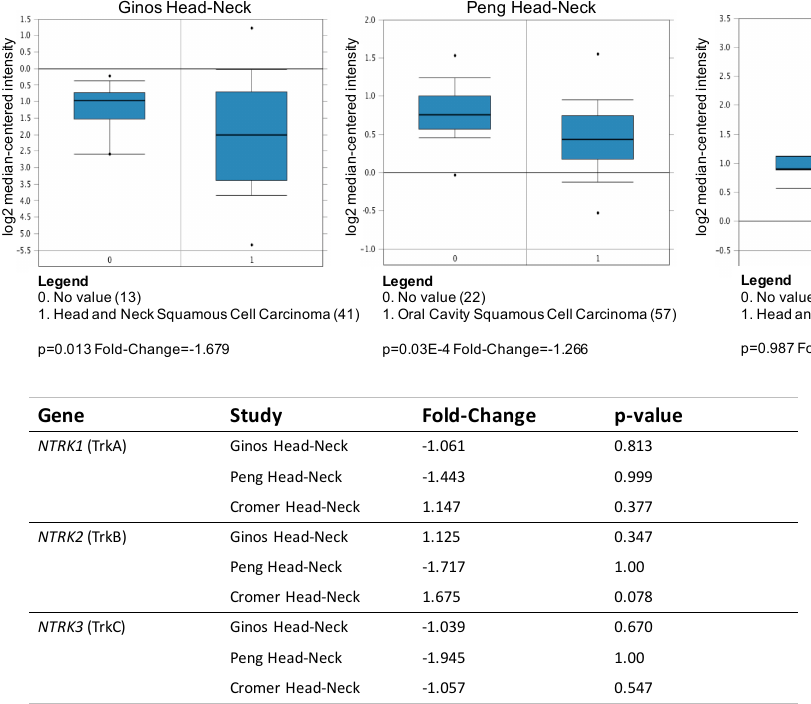
Figure 2. Neurotrophin (NT) receptor expression in vivo. ( A ) CD271 and ( B ) Trk receptors (TrkA, TrkB, TrkC) mRNA fold change from Oncomine (www.oncomine.org) microarray datasets for head and neck squamous cell carcinoma studies: Ginos head-neck (HNSCC vs normal; 54 samples), Peng head-neck (oral cavity SCC vs normal; 79 samples), and Cromer head-neck (HNSCC vs normal; 36 samples).